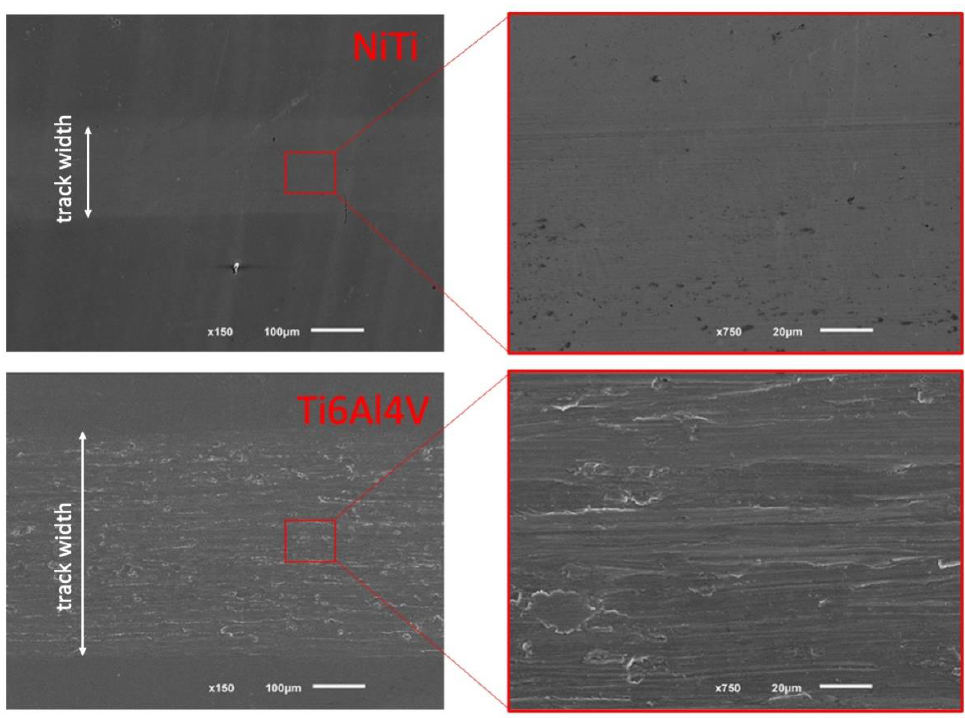
Figure 7. SEM images of the wear track of LB-DED NiTi alloy ( top row) and LB-DED Ti-6Al-4V alloy ( bottom row) [4].